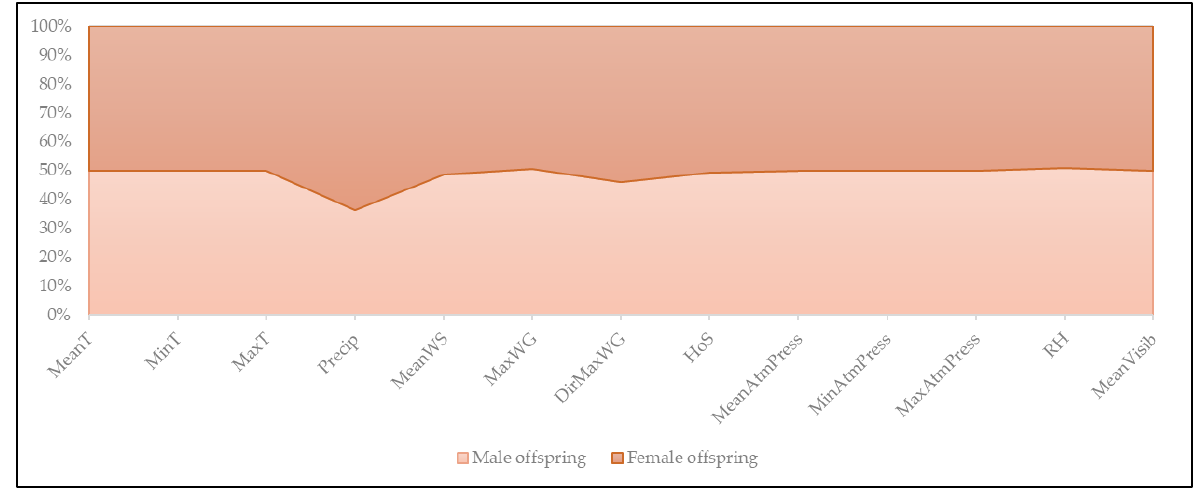
Figure 4. One hundred percent stacked area graph for the comparison of mean values for weather variables at the onsets of parturition depending on the sex of offspring over the study period.